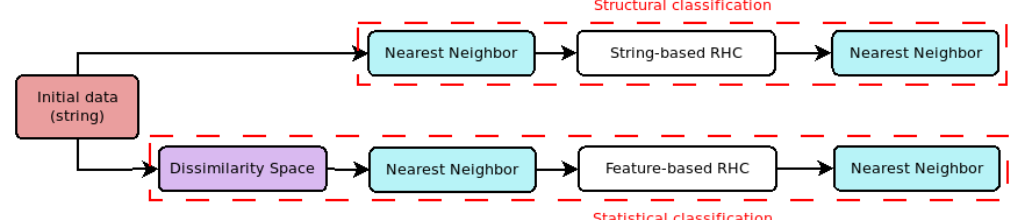
Figure 1. Description of the experimental setup considered. Dissimilarity Space is used for obtaining the feature-based representation of the initial string data. In both string and feature-based representations, classification is performed both before and after the RHC Data Reduction